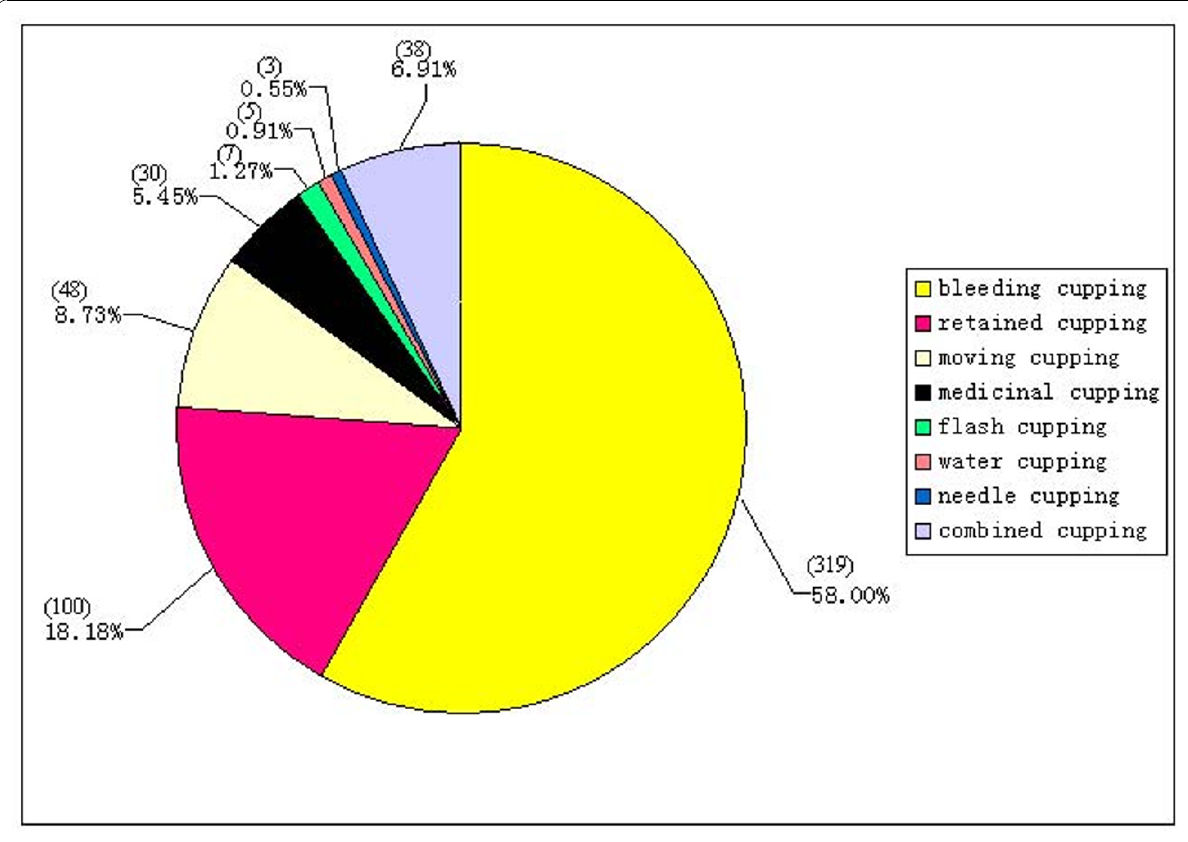
Figure 3 Constituent ratio of types of cupping